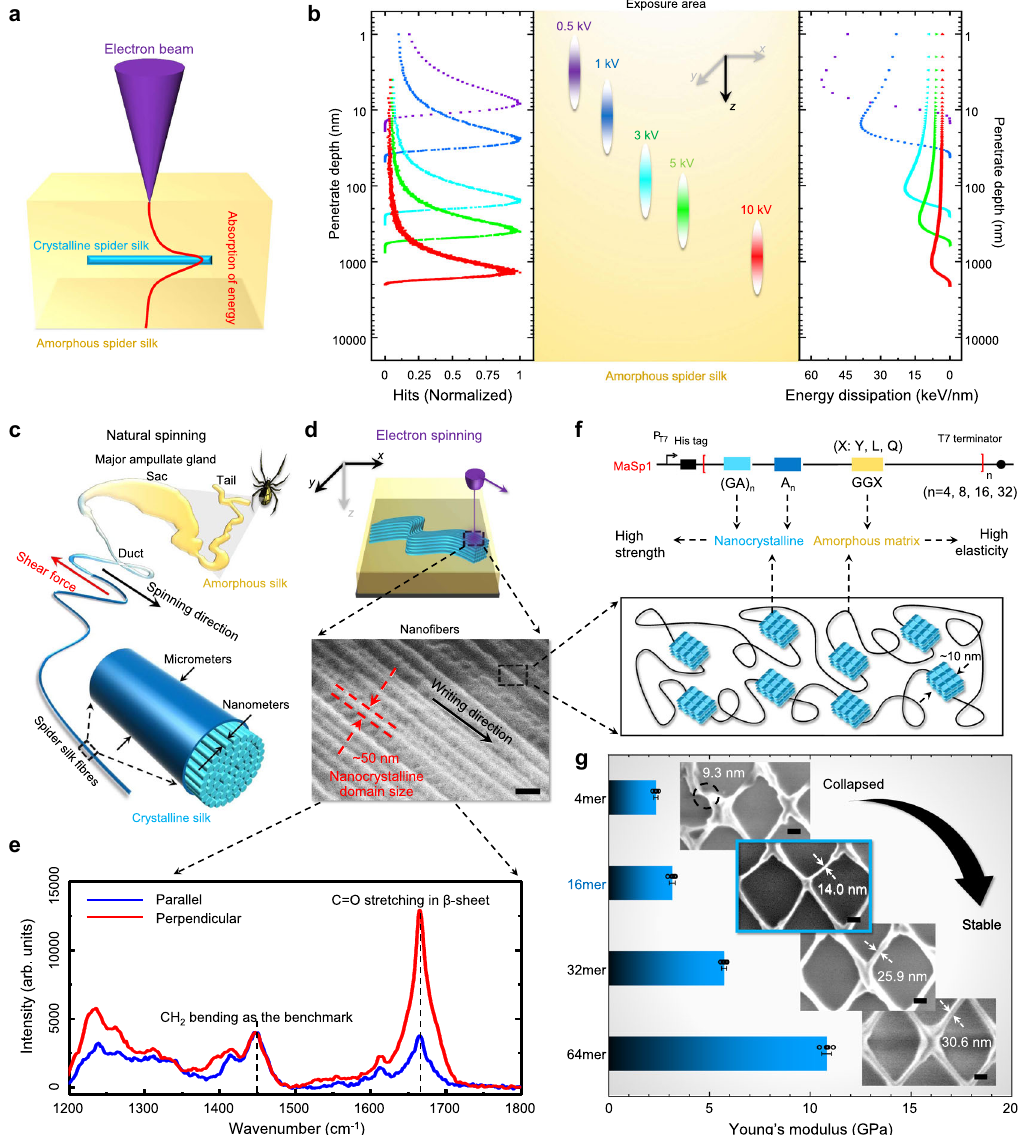
Fig. 2 Mechanism, material, and manufacturing parameters optimization of 3d EBL in recombinant spider silk proteins. a Schematic of 3d EBL in the spider silk resist. b Monte Carlo simulation of electrons ’ behaviors (# of electrons = 10 6 ) in spider silk, including the trajectories (left), the energy dissipations (right), and the probable exposure area of electrons at varying accelerating voltages (0.5 – 10 kV). c Illustration of the natural spinning process of spider silk. d “ Electron spinning ” and the SEM image of the formed spider silk protein nano fi bers following the writing direction. Scale bar, 200 nm. e Polarized micro-Raman spectra of the spun nano fi bers. f Well-de fi ned molecular structures of genetically engineered spider silk proteins. A: Alanine. G: Glycine. Y: Tyrosine. L: Leucine. Q: Glutamine. g Mechanical properties and the minimum feature sizes of 3d EBL using different types of spider silk resists. Scale bars in SEM images (insets), 100 nm. n = 5 for each group. The error bars denote standard deviations of the